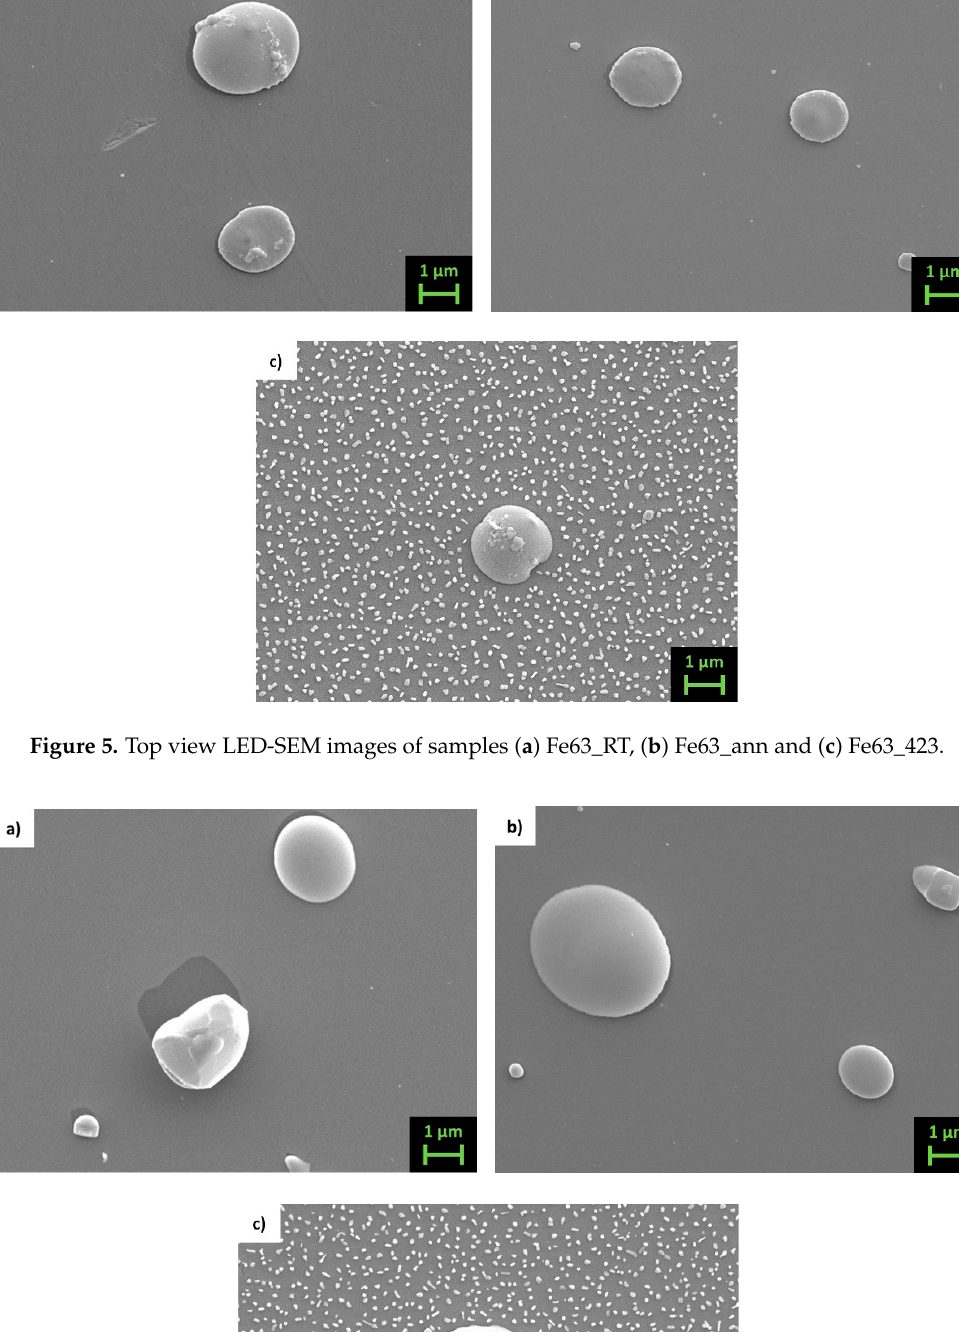
Materials 2021 , 14 , x FOR PEER REVIEW